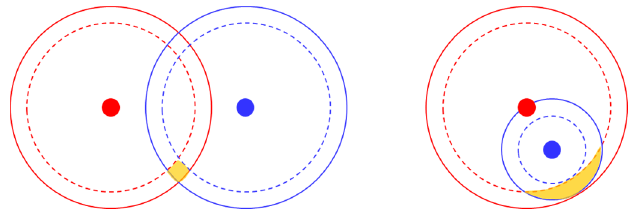
Figure 4. An example of horizontal intersection with distance error.